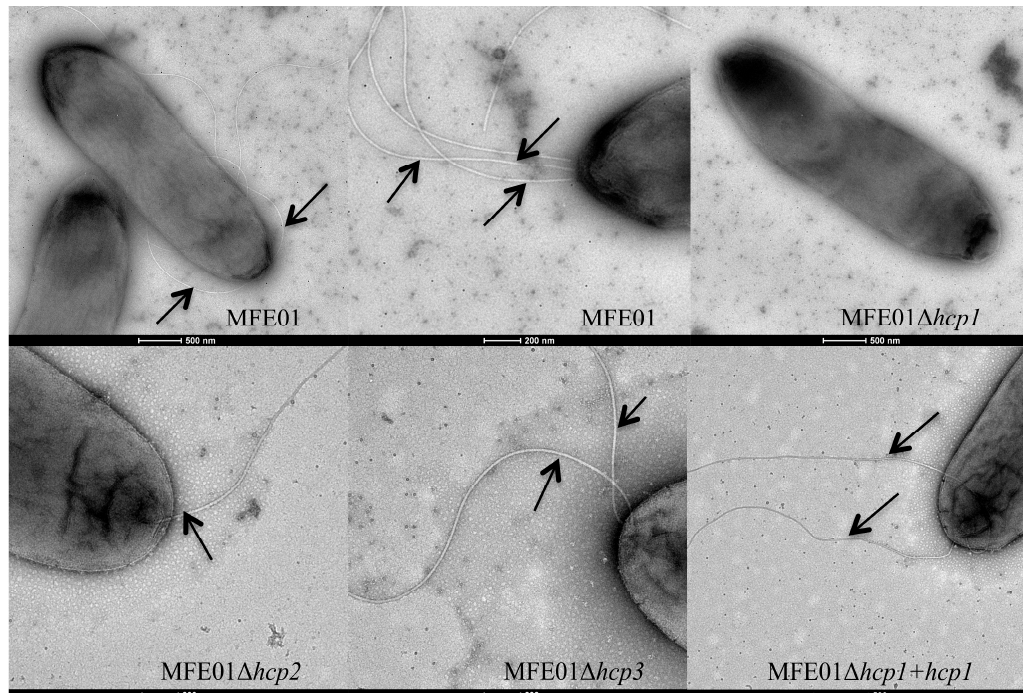
Figure 2. Flagella of P. fluorescens MFE01 and derivatives. Transmission electron microscopy images of bacteria grown at 28 ◦ C (negative stain). All tested strains (MFE01, MFE01 ∆ hcp1 , MFE01 ∆ hcp2 , and MFE01 ∆ hcp3 ) contained the empty pPSV35 vector. Arrows indicate a flagellum. These images are representative of at least 35 bacteria for each strain.